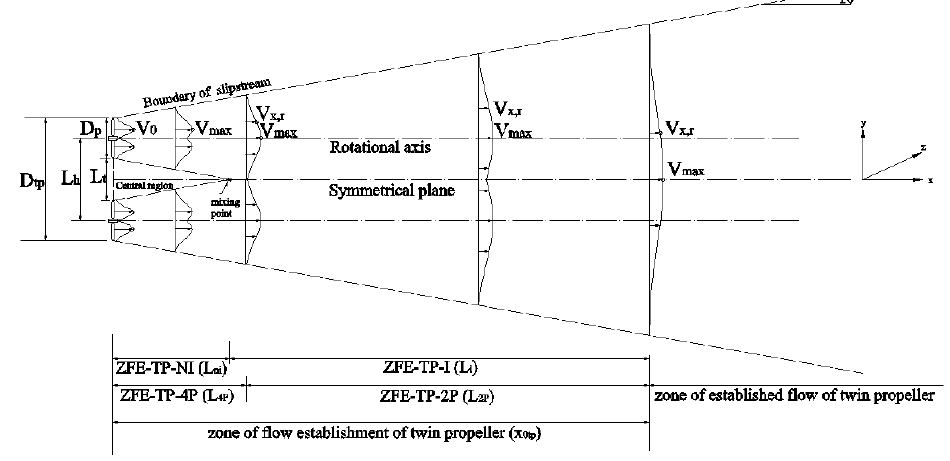
Figure 1. Flow structure of a twin-propeller jet [15].